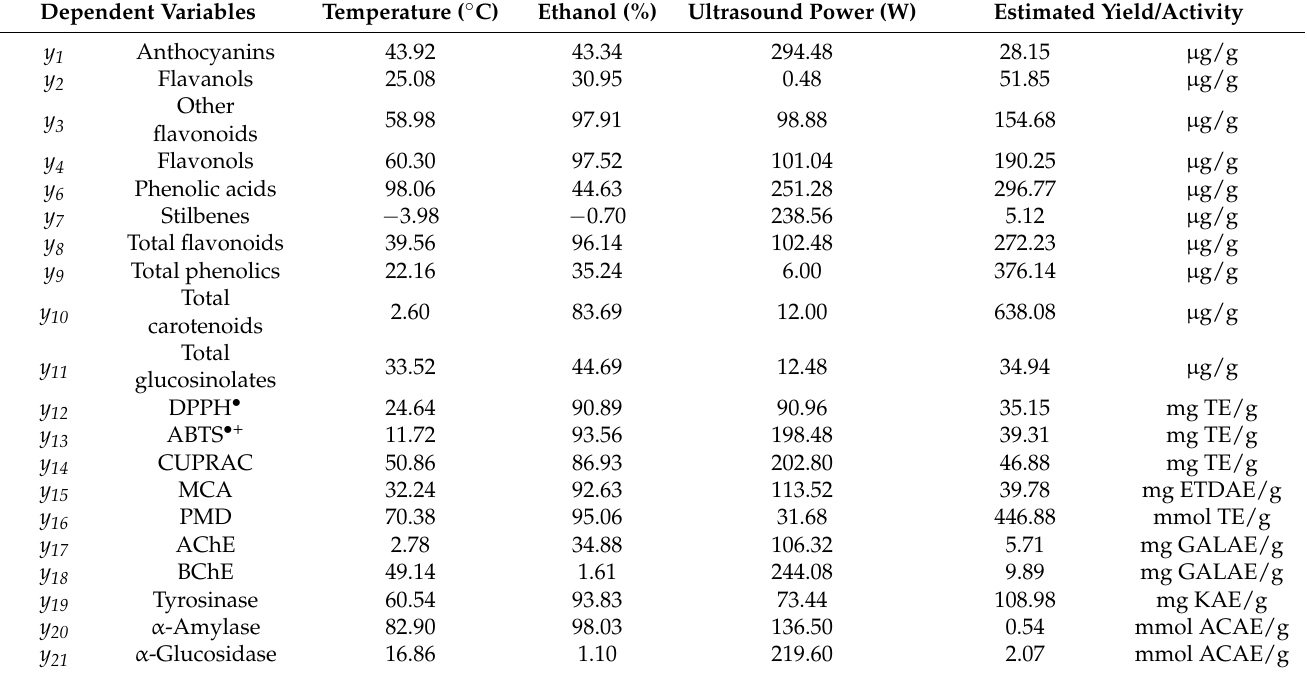
Table 6. Canonical analysis used to predict the maximum response values among all the predictor combinations at d = ±